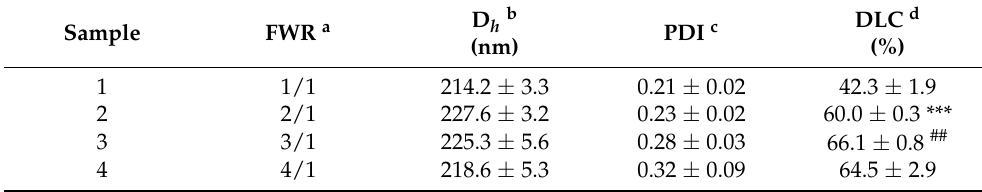
Table 1. Results of NRG NPs at different